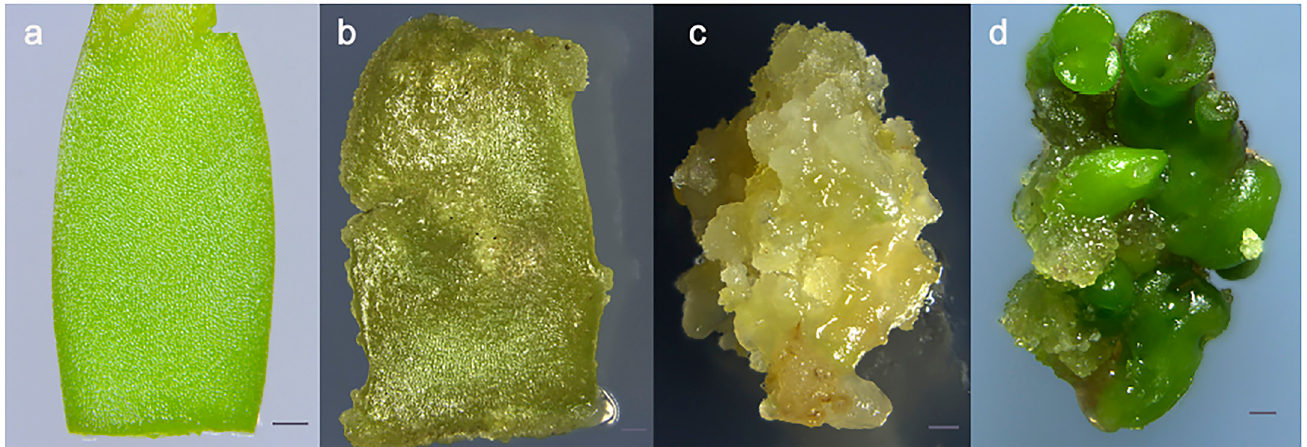
Figure 1. Somatic embryogenesis in alfalfa at four developmental phases used for RNA-Seq analysis; ( a ) Cotyledon cutting; ( b ) Non-embryogenic callus; ( c ) Embryogenic callus; ( d ) Cotyledon embryo. Bar =1 mm.